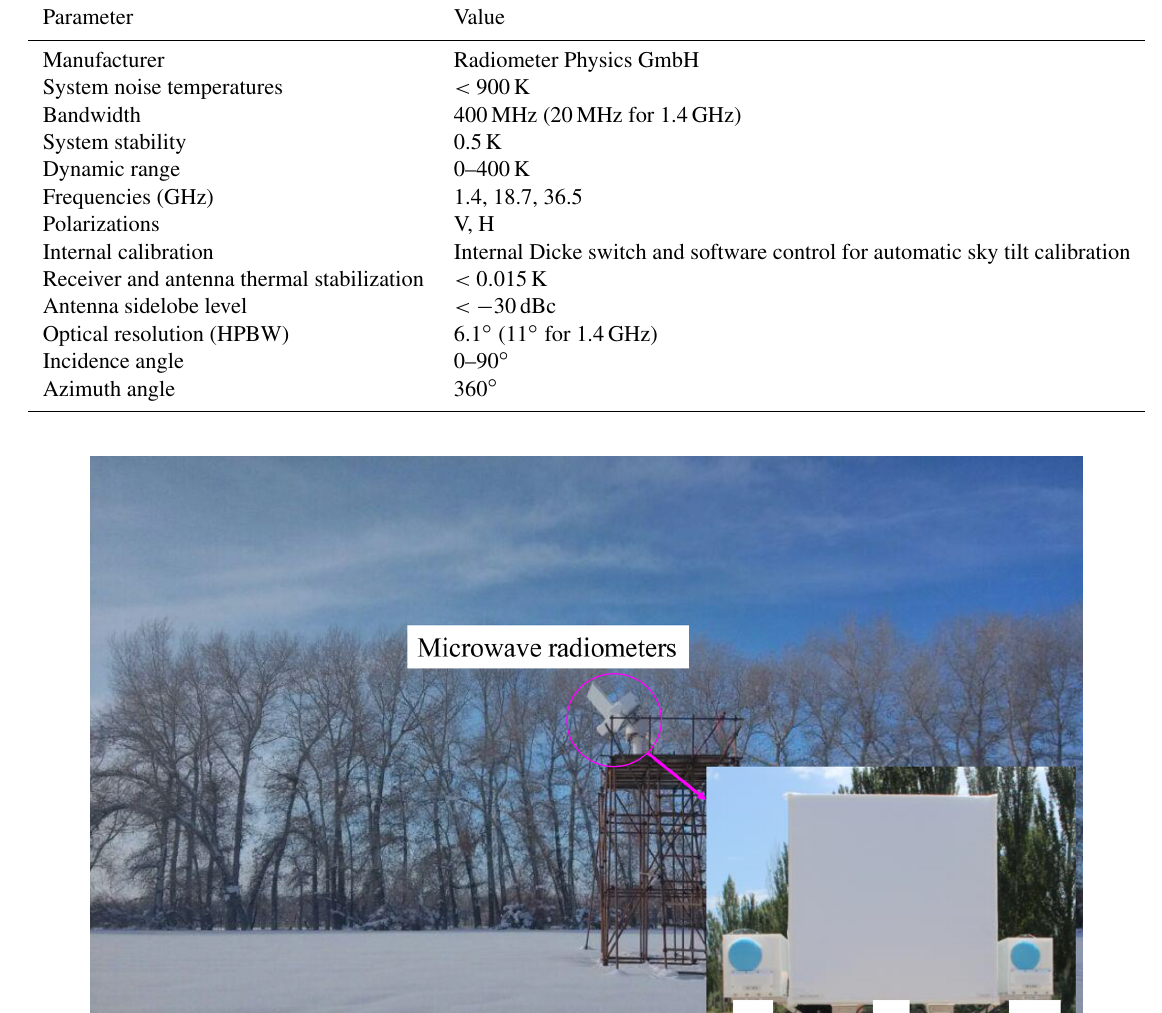
Table 2. Technical specifications of the RPG-6CH-DP microwave radiometer.